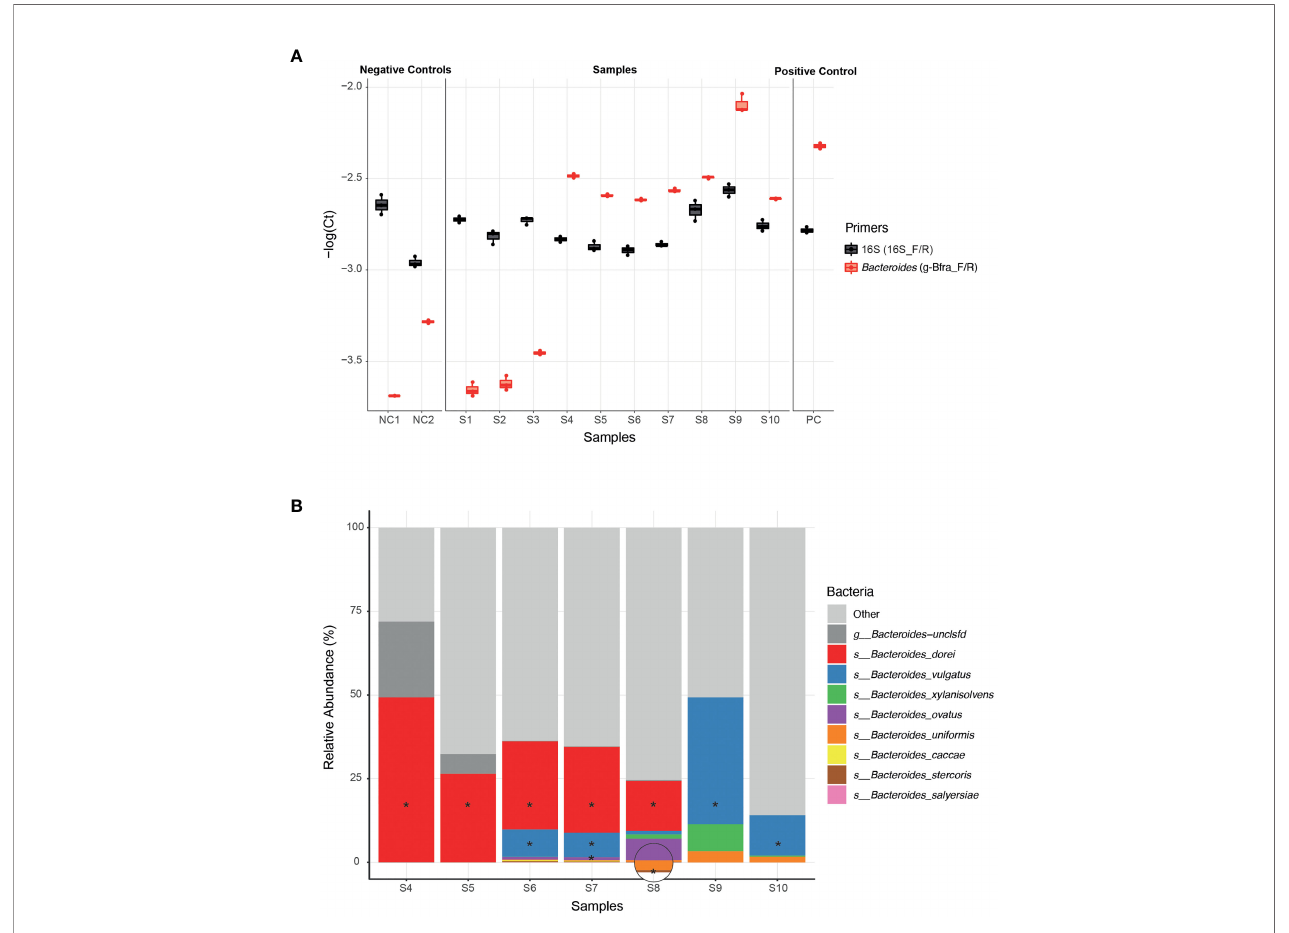
FIGURE 1 | Isolation of Bacteroides strains from infant stool samples. (A) A comparison of qPCR Ct (Cycle threshold; Methods ) values of infant stool samples DNA, using Bacteroides -speci fi c primers (g-Bfra-F, g-Bfra-R) and universal 16S primers (16_F, 16_R). Each qPCR reaction was performed in triplicates, and each replicate is indicated by a dot. (B) Relative abundance of Bacteroides species, as identi fi ed by 16S rRNA gene sequencing of stool samples found to contain Bacteroides according to qPCR screening. Bacteroides species that were successfully isolated from stool samples are indicated with